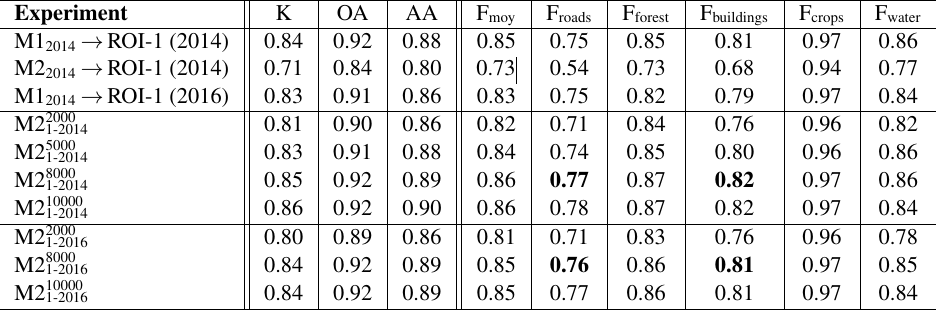
Table 1. Assessment of the training and testing schemes designed in this